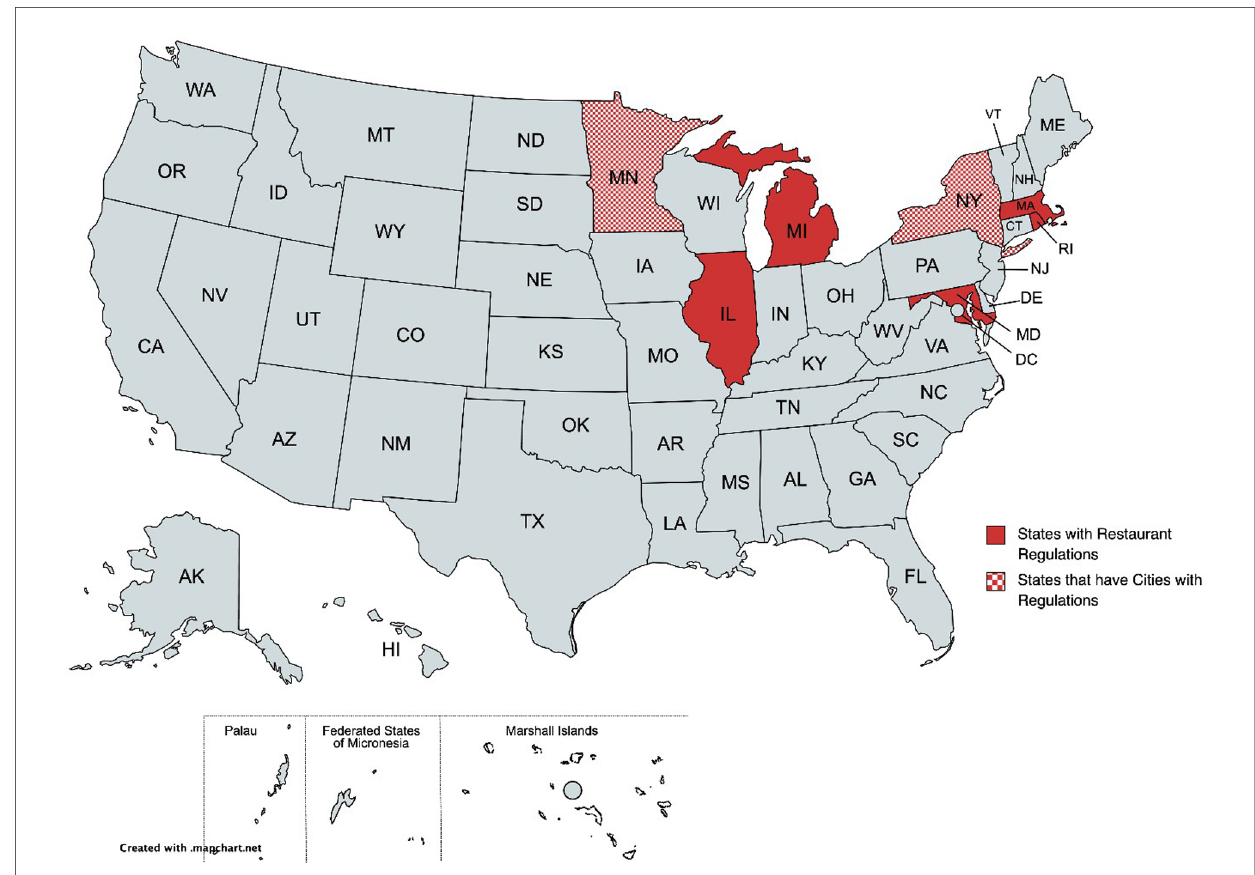
FIGURE 2 States with restaurant allergen labeling